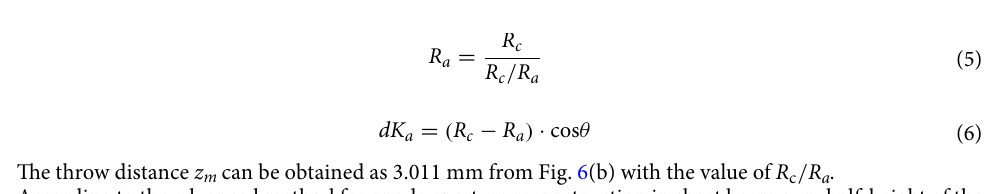
Figure 7. Beam trajectory in two transverse directions for the two models. ( a ) In the y–O-z plane of Model I. ( b ) In the x-O-z plane of Model I. ( c ) In the y–O-z plane of Model II. ( d ) In the x-O-z plane of Model